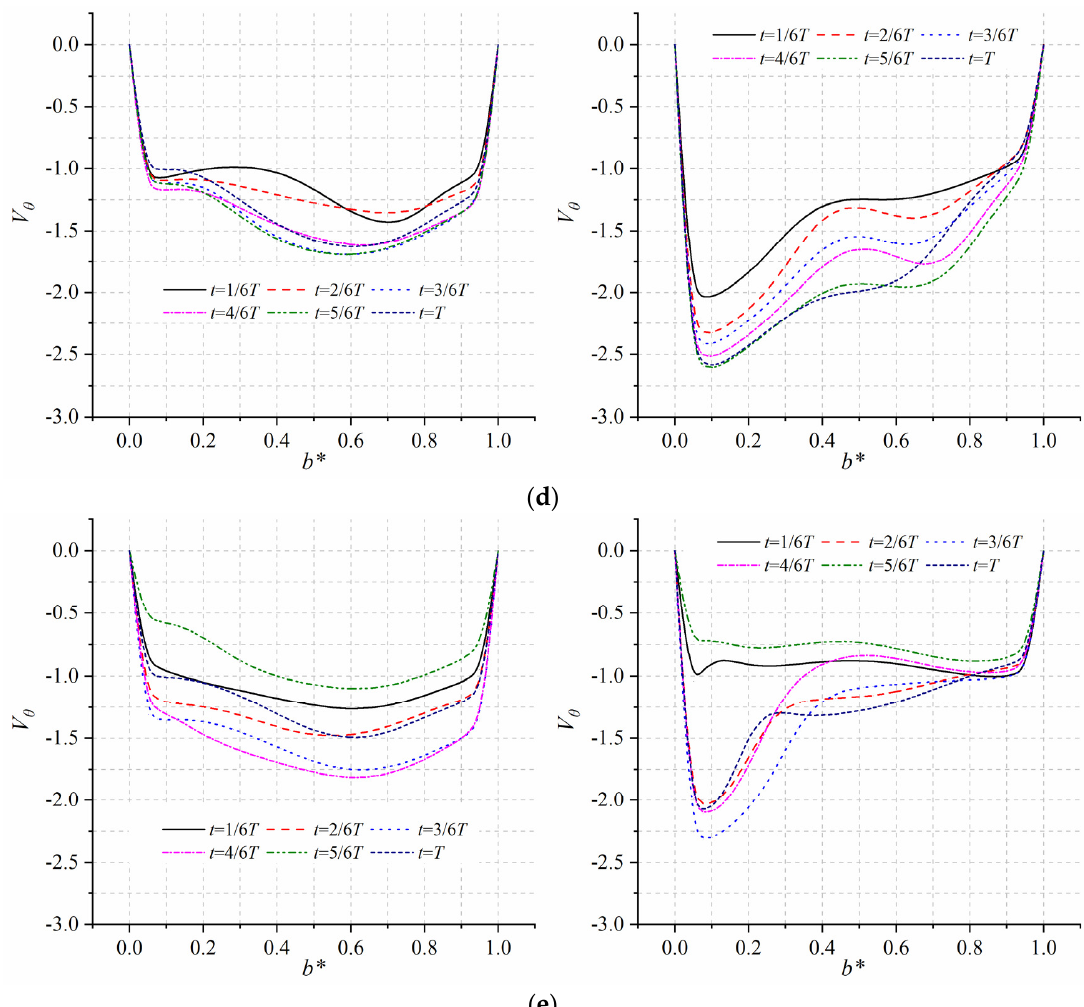
Figure 10. ( a – e ) Distributions of instantaneous normalized circumferential velocity along the hub-to-shroud direction for flow near the pressure surface (left) and suction surface (right) for (from top to bottom) U rot /U ref = − 0.5, − 0.3, 0.0, 0.3 and 0.5.